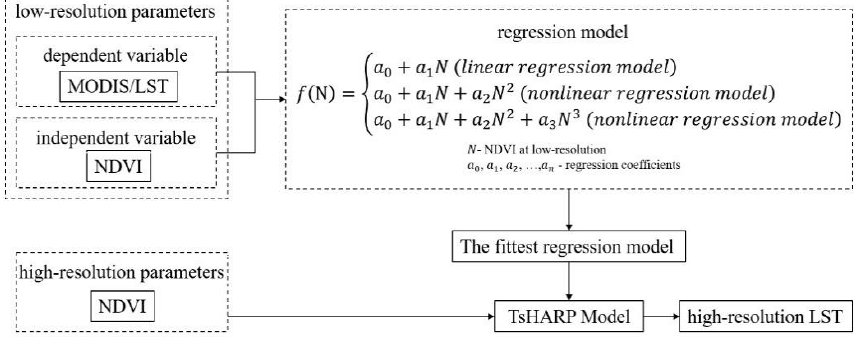
Figure 1. Building process of the thermal sharpen (TsHARP) model.